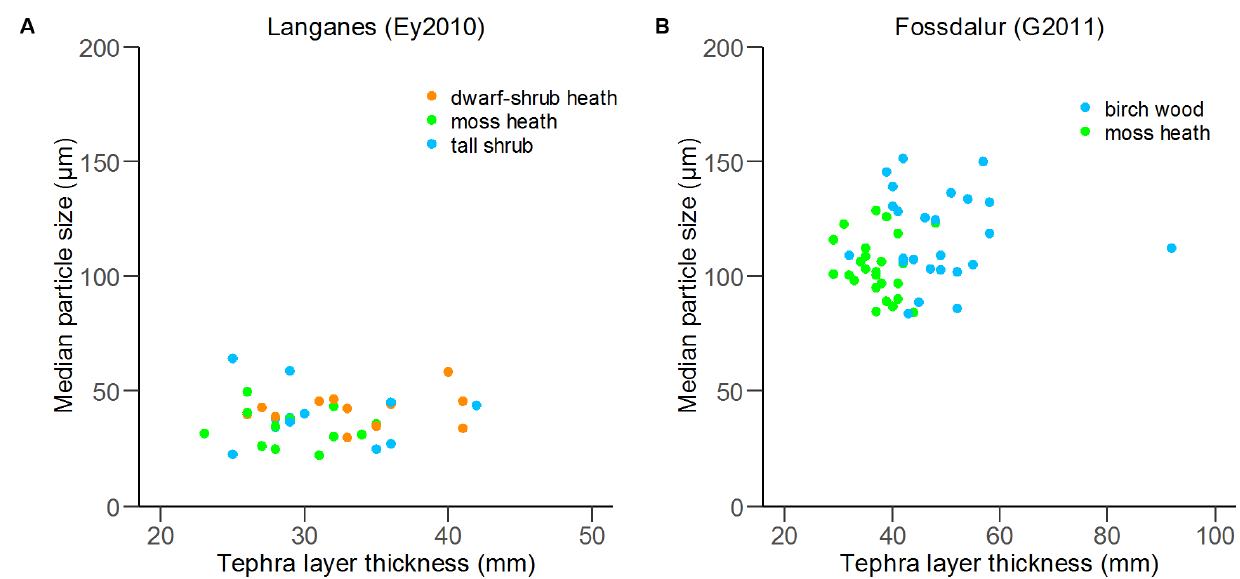
Figure 7: Association between median particle-size and tephra layer thickness at [A] Langanes (Ey2010, n = 36) and [B] Fossdalur (G2011, n =